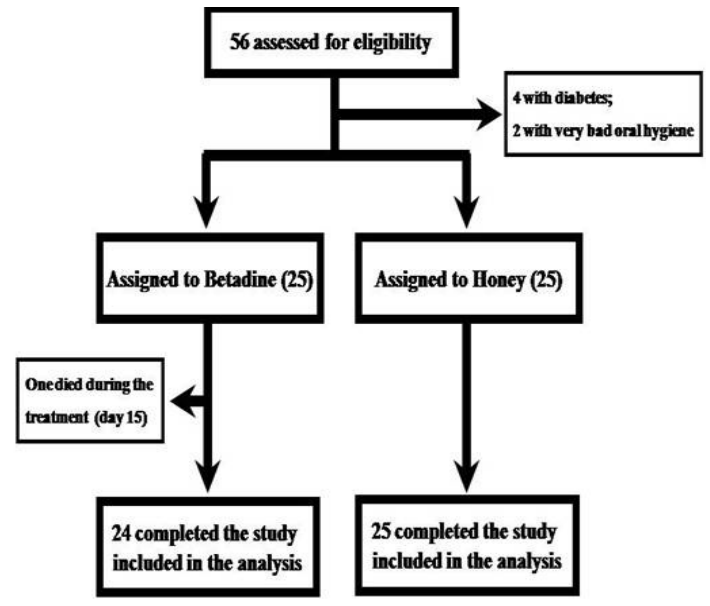
Figure 1. Patient flow in the randomized controlled study.